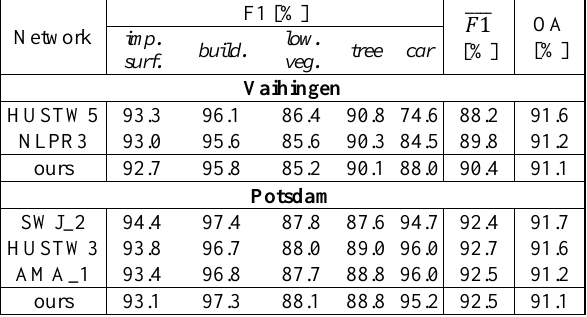
Table 4. Comparison to the state-of-art (with eroded reference). 𝐹1̅̅̅̅ : average F1 score, OA: Overall